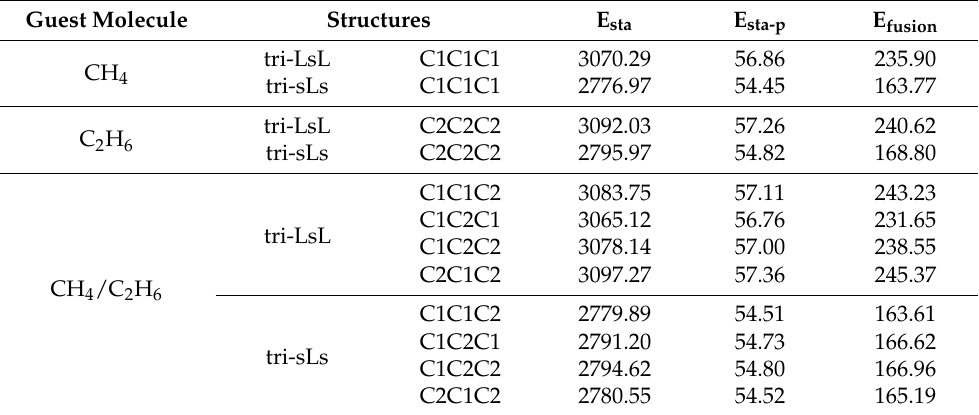
The stabilization energy (E sta , kJ mol − 1 ), stabilization energy per H 2 O molecule (E sta-p , kJ mol − 1 ), and fusion energy (E fusion , kJ mol − 1 ) of three guest molecules (CH 4 , C 2 H 6 , and mixed CH 4 /C 2 H 6 ) in tri-cage